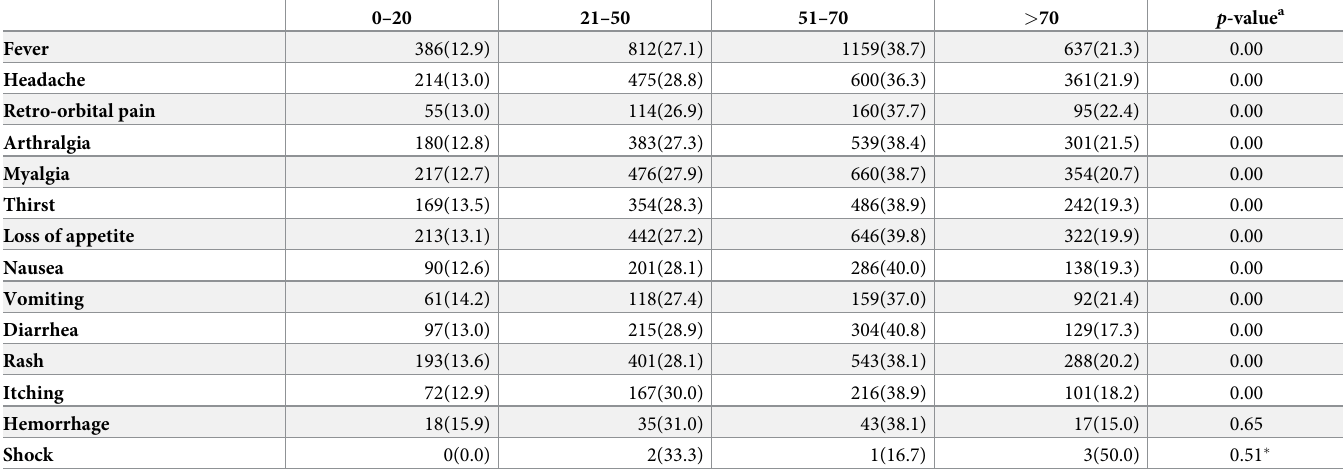
were not included in the dengue diagnosis and notification criteria in Taiwan. The confirmed cases showed significantly different clinical manifestations with age ( p < 0.05), except for hem- orrhage and shock ( p > 0.05, Table 4). There were 795 patients with confirmed cases who had chronic diseases, with hypertension and diabetes being the most common (Table 5). DHF had Table 4. Comparison of the clinical manifestations with age of dengue-infected